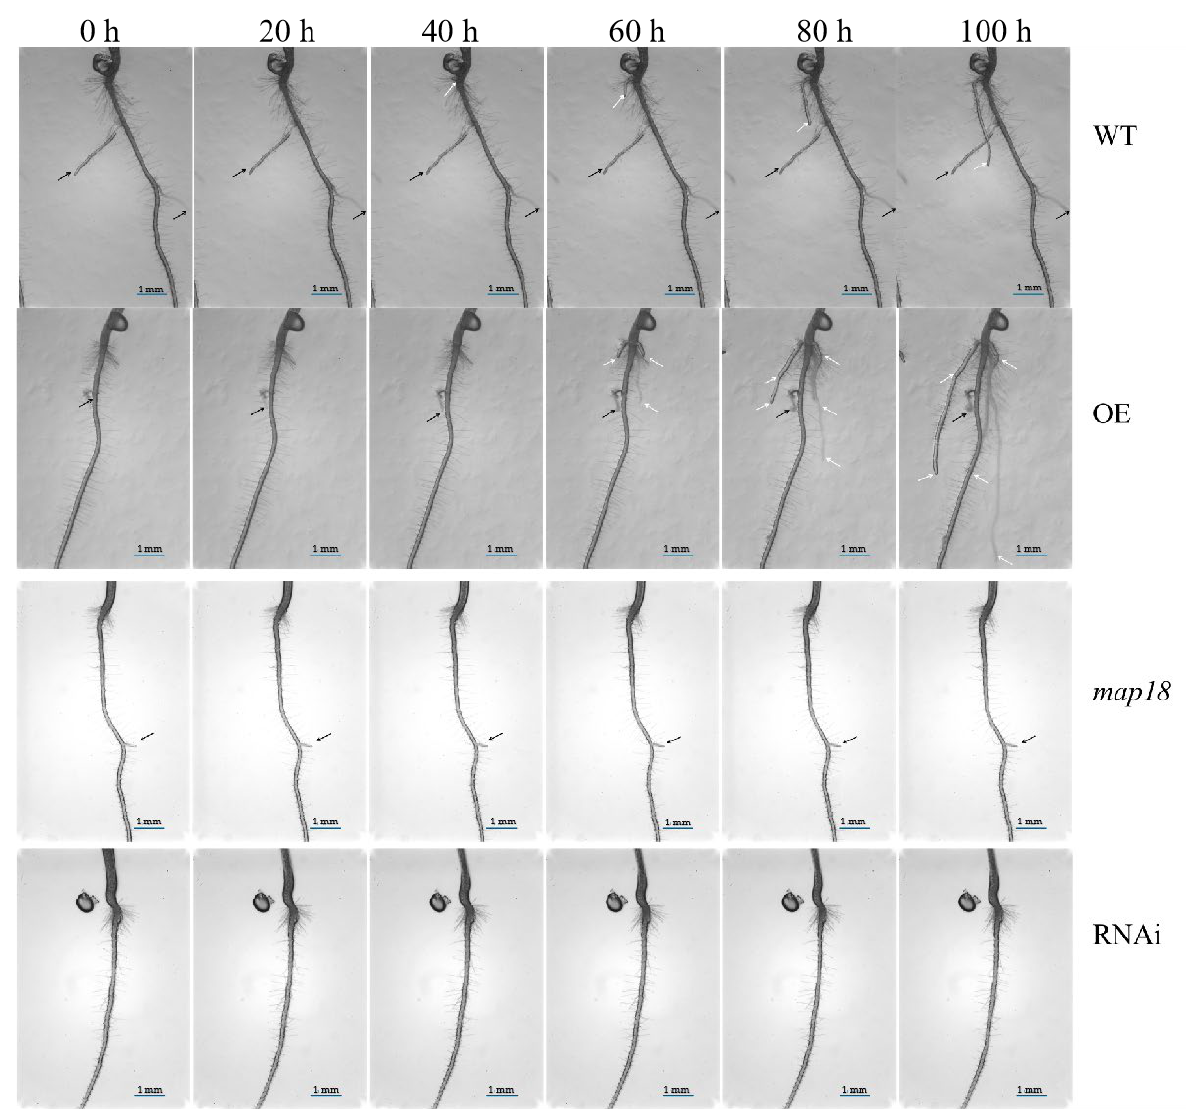
Figure A4. Lateral root generation process after UV-B radiation on A. thaliana seedlings recorded via DynaPlant. Scale bars represent 1mm. The white arrows show new regenerated lateral roots. The black arrows show developed lateral roots which stop elongation.